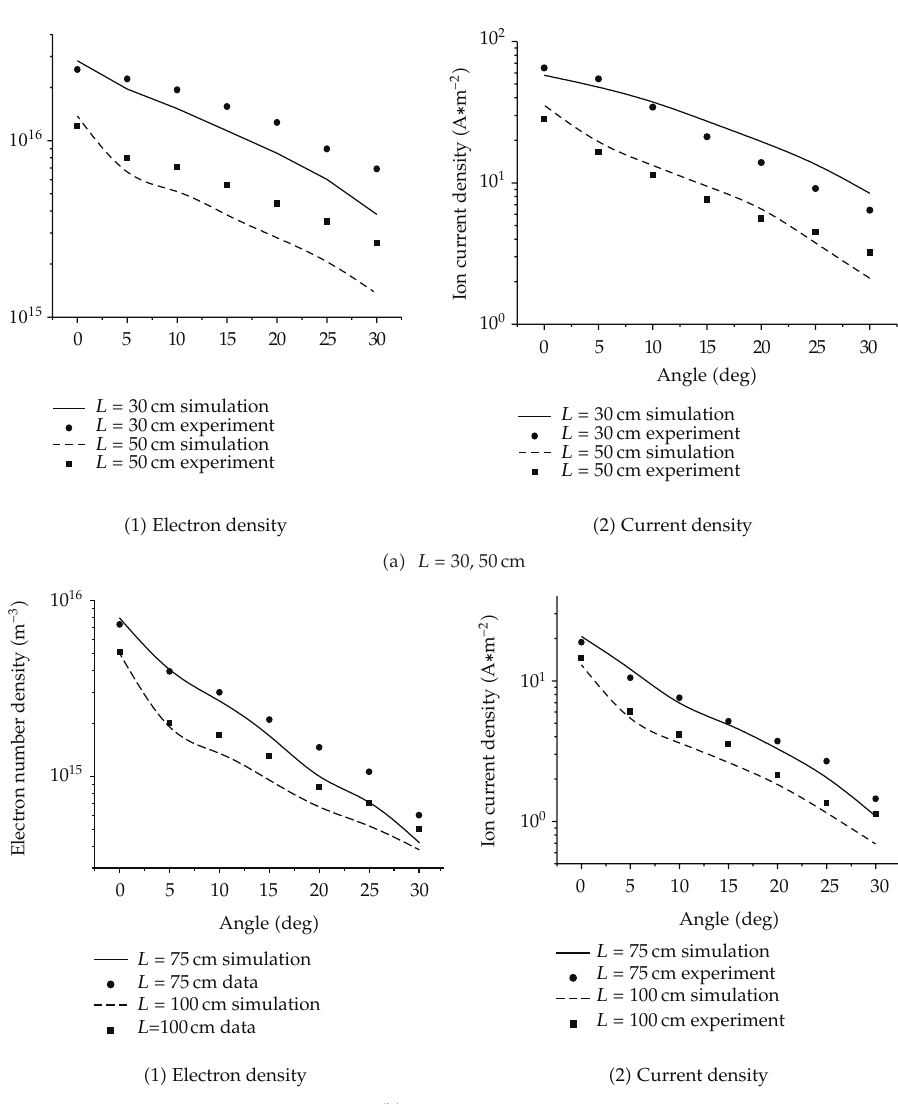
Figure 4: Comparisons between computational results and experimental